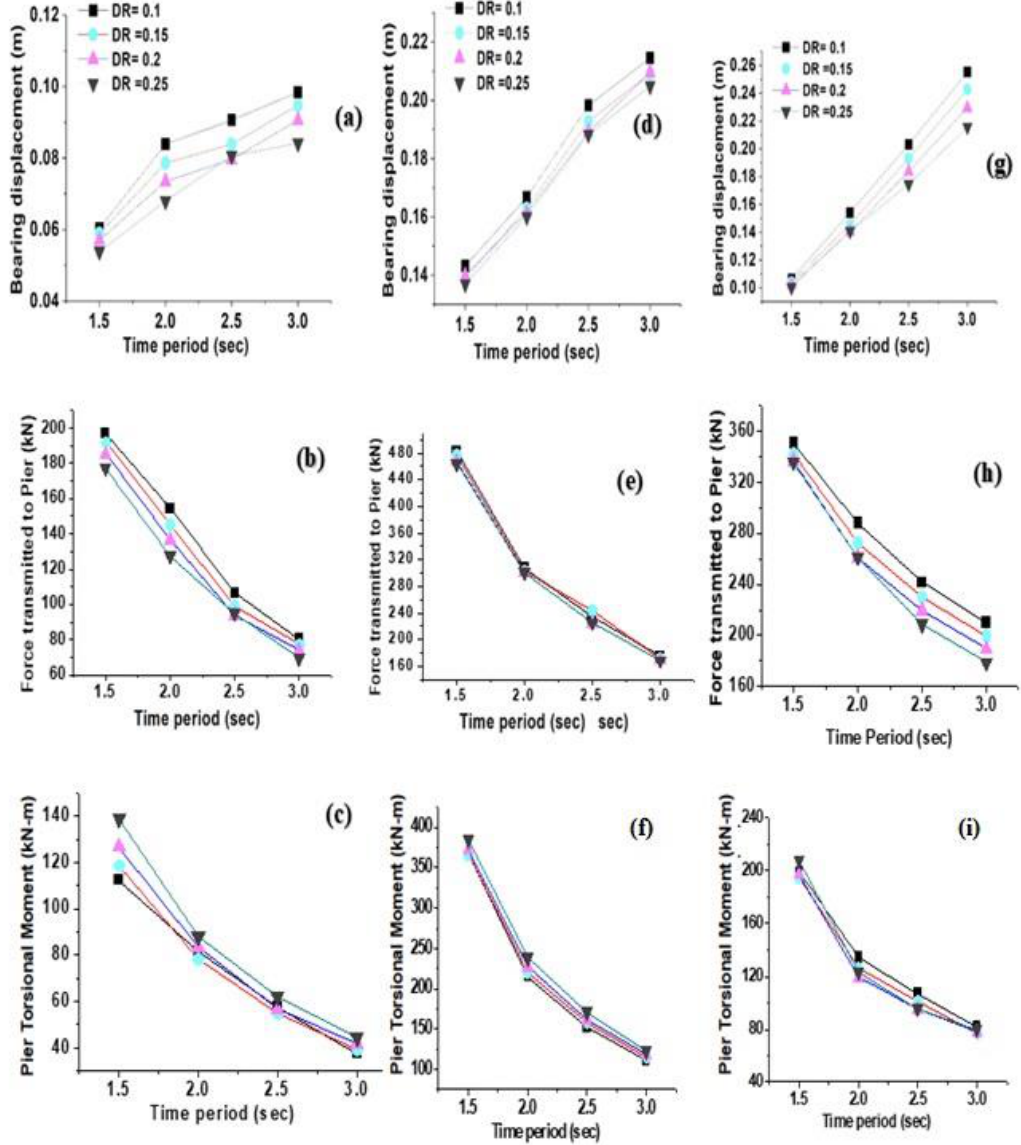
Figure 10. Response sensitivity of the isolated bridge with respect to the time period of LRB under uni-directional (i) Imperial Valley ( a – c ), (ii) Kobe ( d – f ), and (iii) Turkey ( g – i ) ground motions.